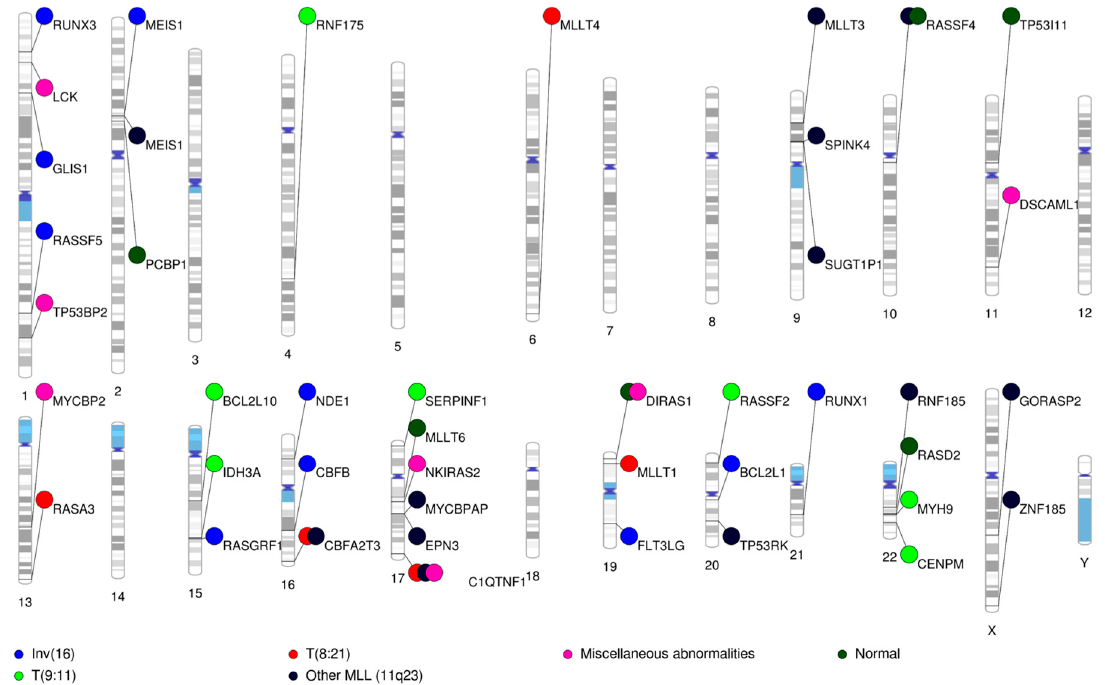
Figure 4. Chromosome map depicting chromosomal location of the differential methylated genes unique to the cytogenetic features. Key to the cytogenetics—blue: inv(16); red: t(8:21); pink: miscellaneous; dark green: normal cytogenetics; green: t(9:11); and black: other MLL (11q23) rearranged AML.